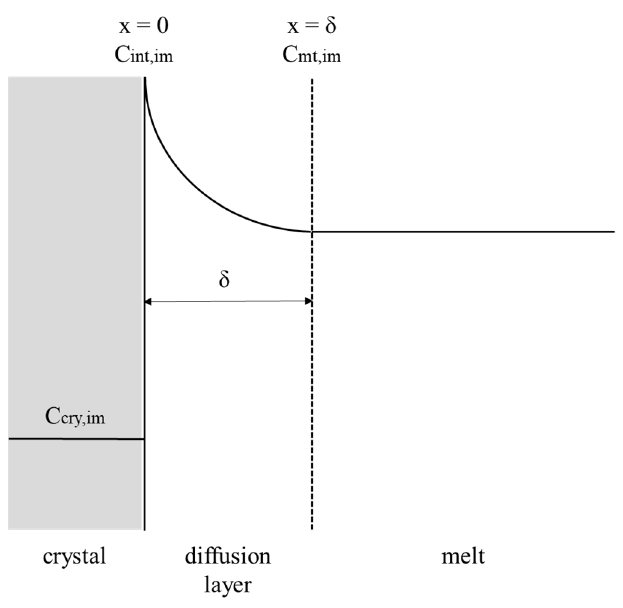
Figure 2. Schematic diagram of the impurity concentration in the mass transfer boundary layer along the x direction perpendicular to the crystal-melt interface.